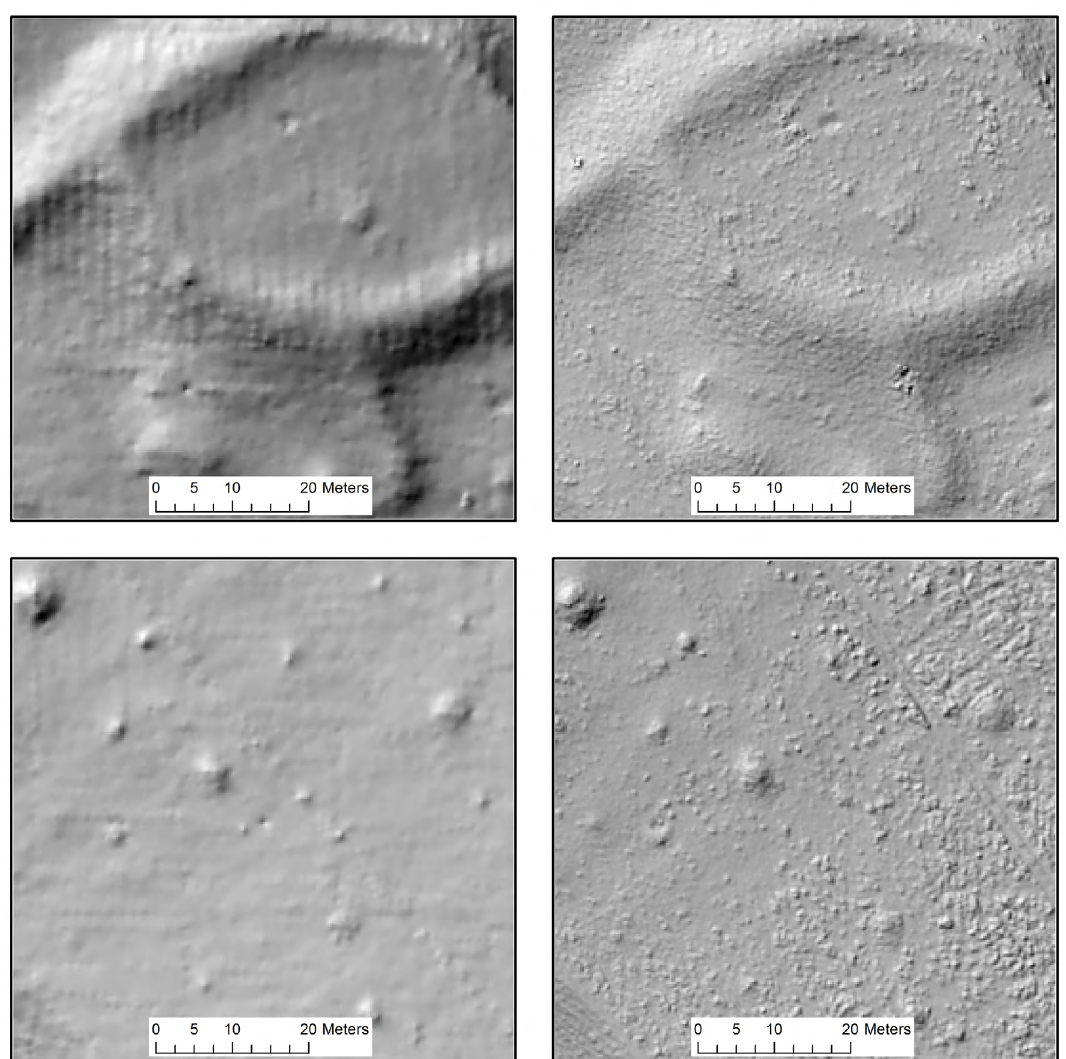
Figure 9: Comparison of data detail and defects in area of interest 1 (top) and area of interest 2 (bottom) at Kaymakçı. The decreased granularity of surface models resulting from RTK GNSS survey (left) compared to UAVP survey (right) is a factor of data density. Note the N–S (top) and E–W (bottom) trending striping defects in the RTK GNSS models versus the stone-by- stone detail (top) and clearly delineated modern tractor ruts and low vegetation (bottom) of the UAVP